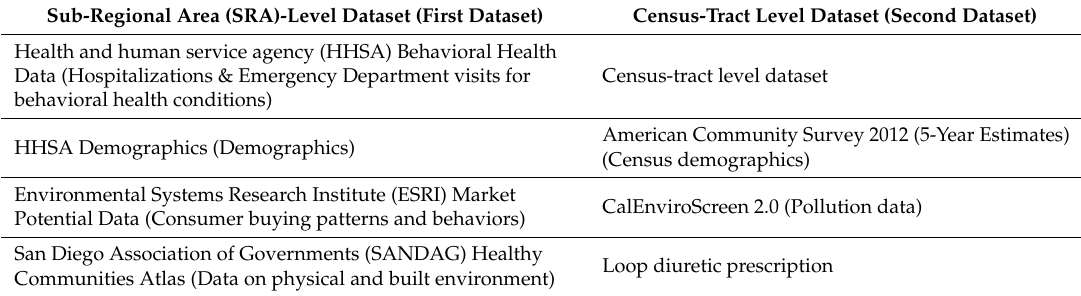
Table 5. Dataset integration. The first dataset has restrictions of geographic granularity due to privacy reasons. The second dataset can be used to complement to improve the quality of data sources (Adapted from